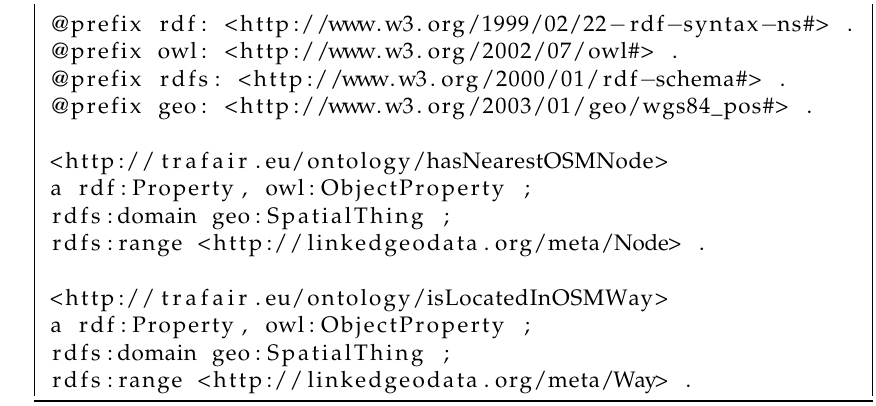
Figure 5. Definition of the “isLocatedInOSMWay” and the “hasNearestOSMNode”